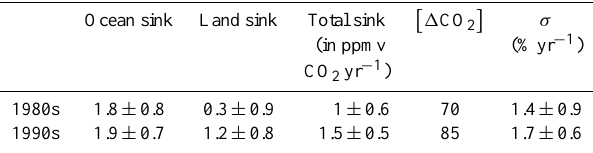
0.1 Fig. A1. Measured perturbations in atmospheric CO 2 concentrations from a baseline of 275ppmv, compared Fig. C1. Measured perturbations in atmospheric CO 2 concentra- with historical estimates of global GDP in inflation adjusted 1990 dollars, with associated year markers, and a tions from a baseline of 275ppmv, compared with historical esti- linear fit to the data. mates of global GDP in inflation adjusted 1990 dollars, with asso- ciated year markers, and a linear fit to the